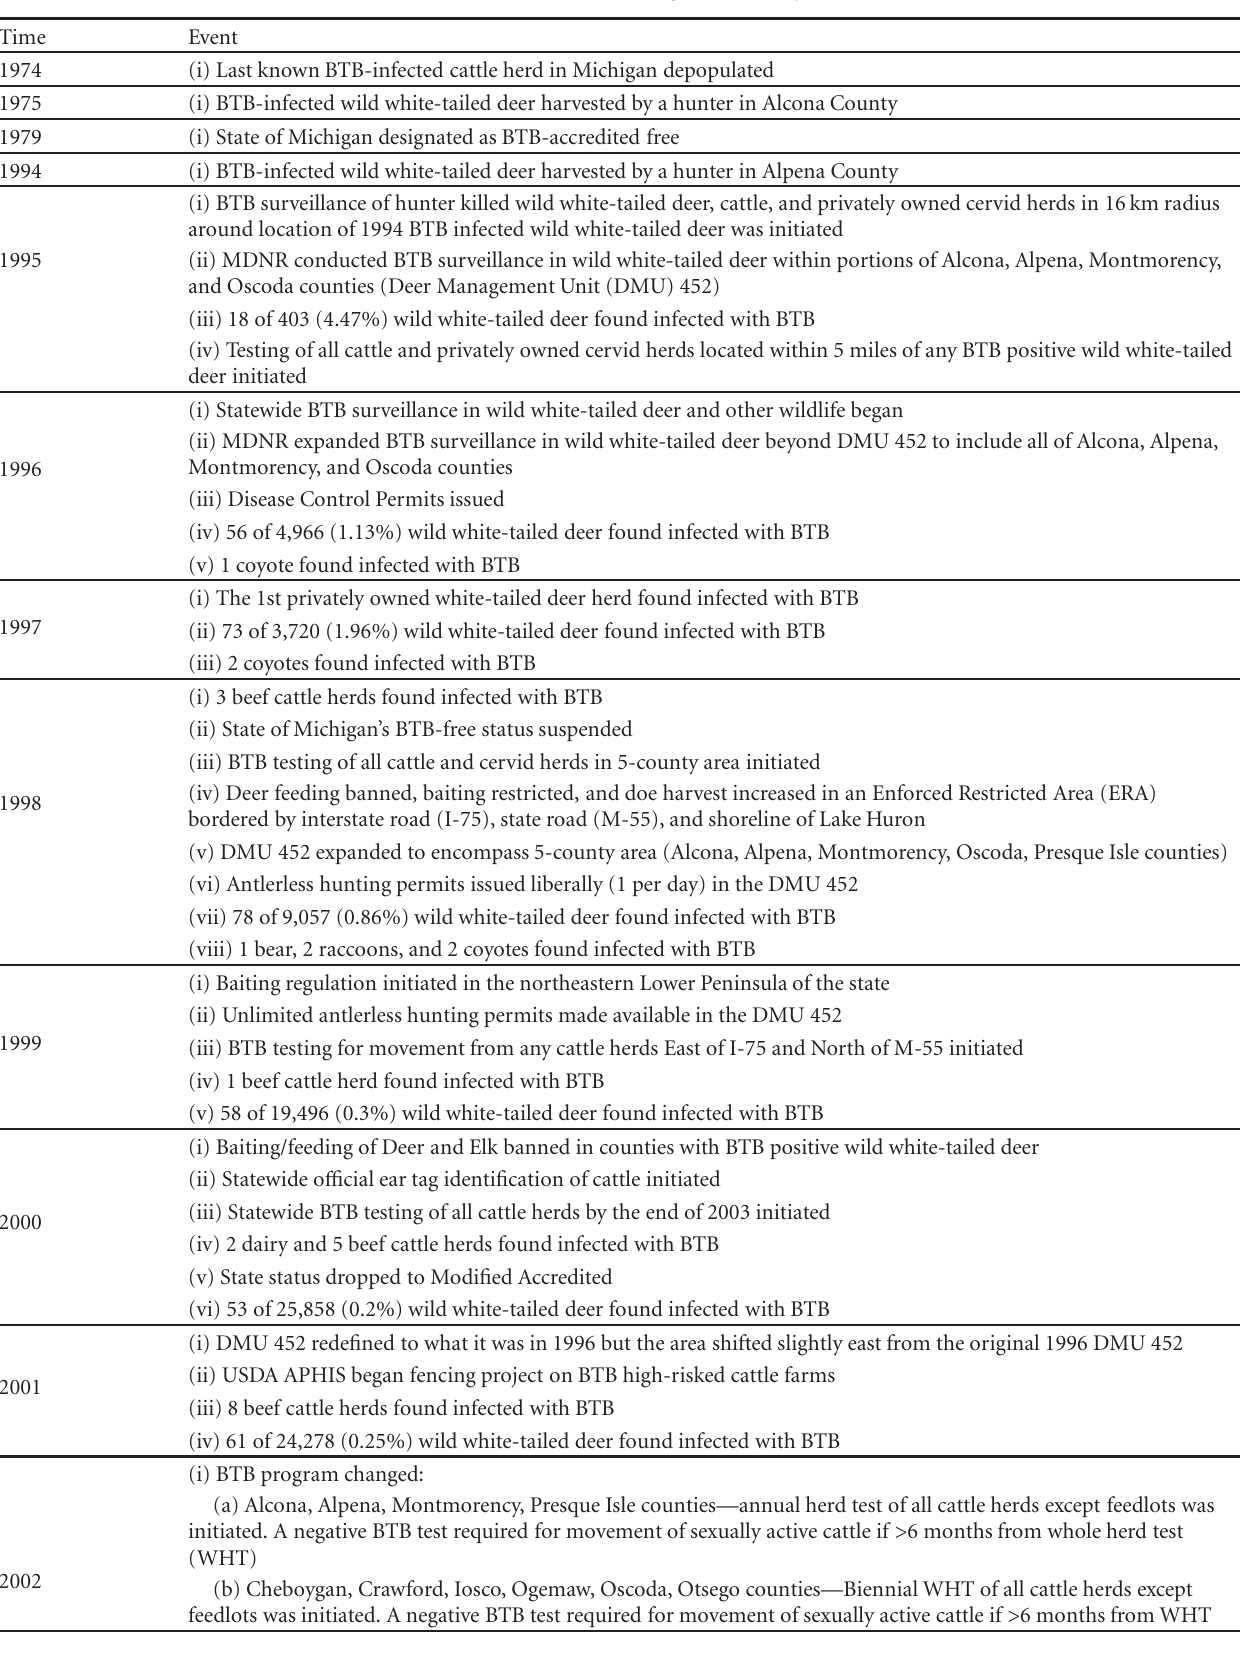
Table 2: Timeline of BTB in Michigan (1975–July